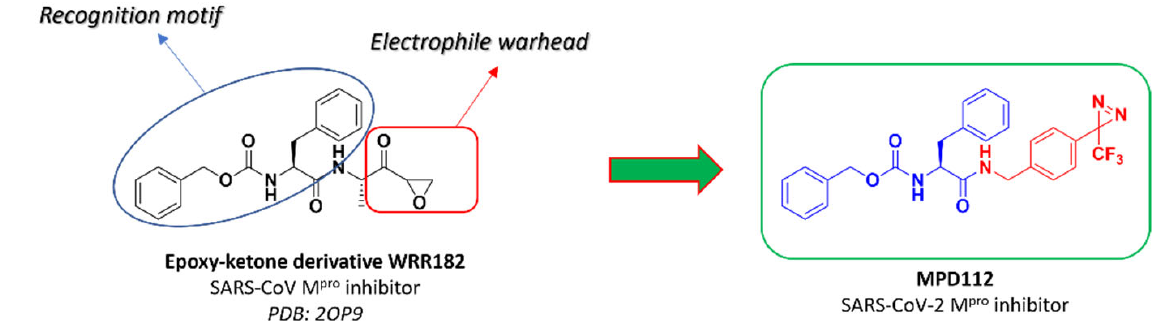
Figure 2. Design of the SARS-CoV-2 M pro inhibitor MPD112 .